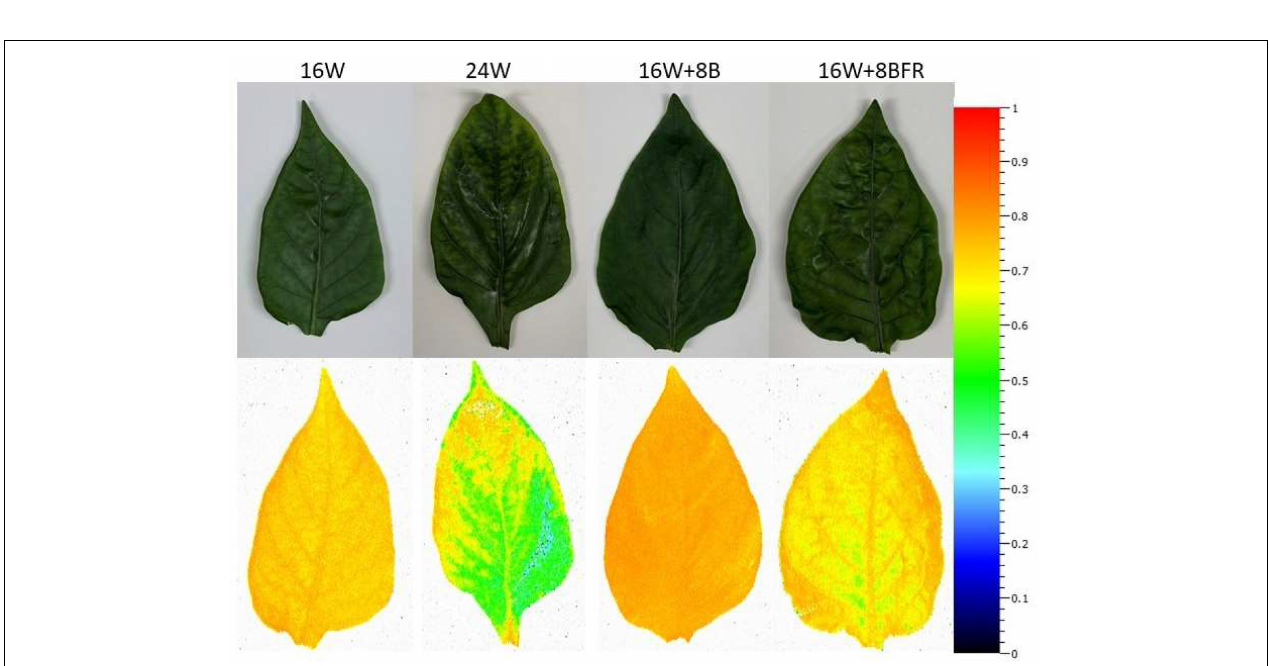
Frontiers in Plant Science |